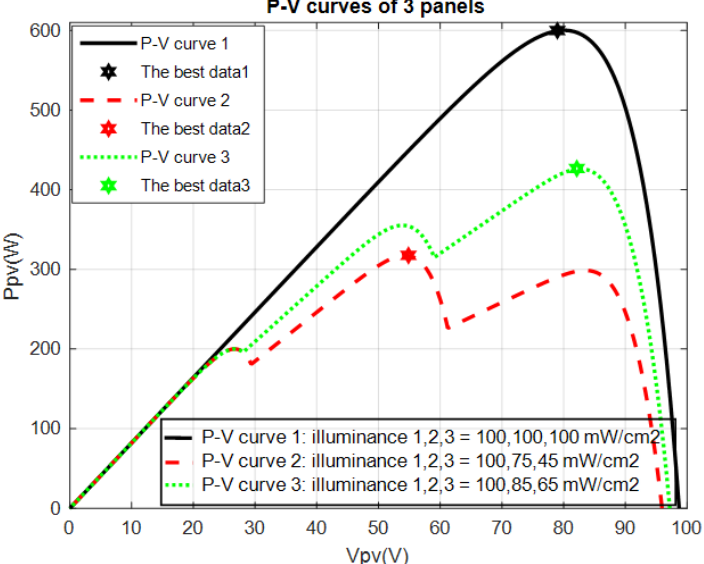
Figure 6. P-V curve characteristics of three serial PV panels.